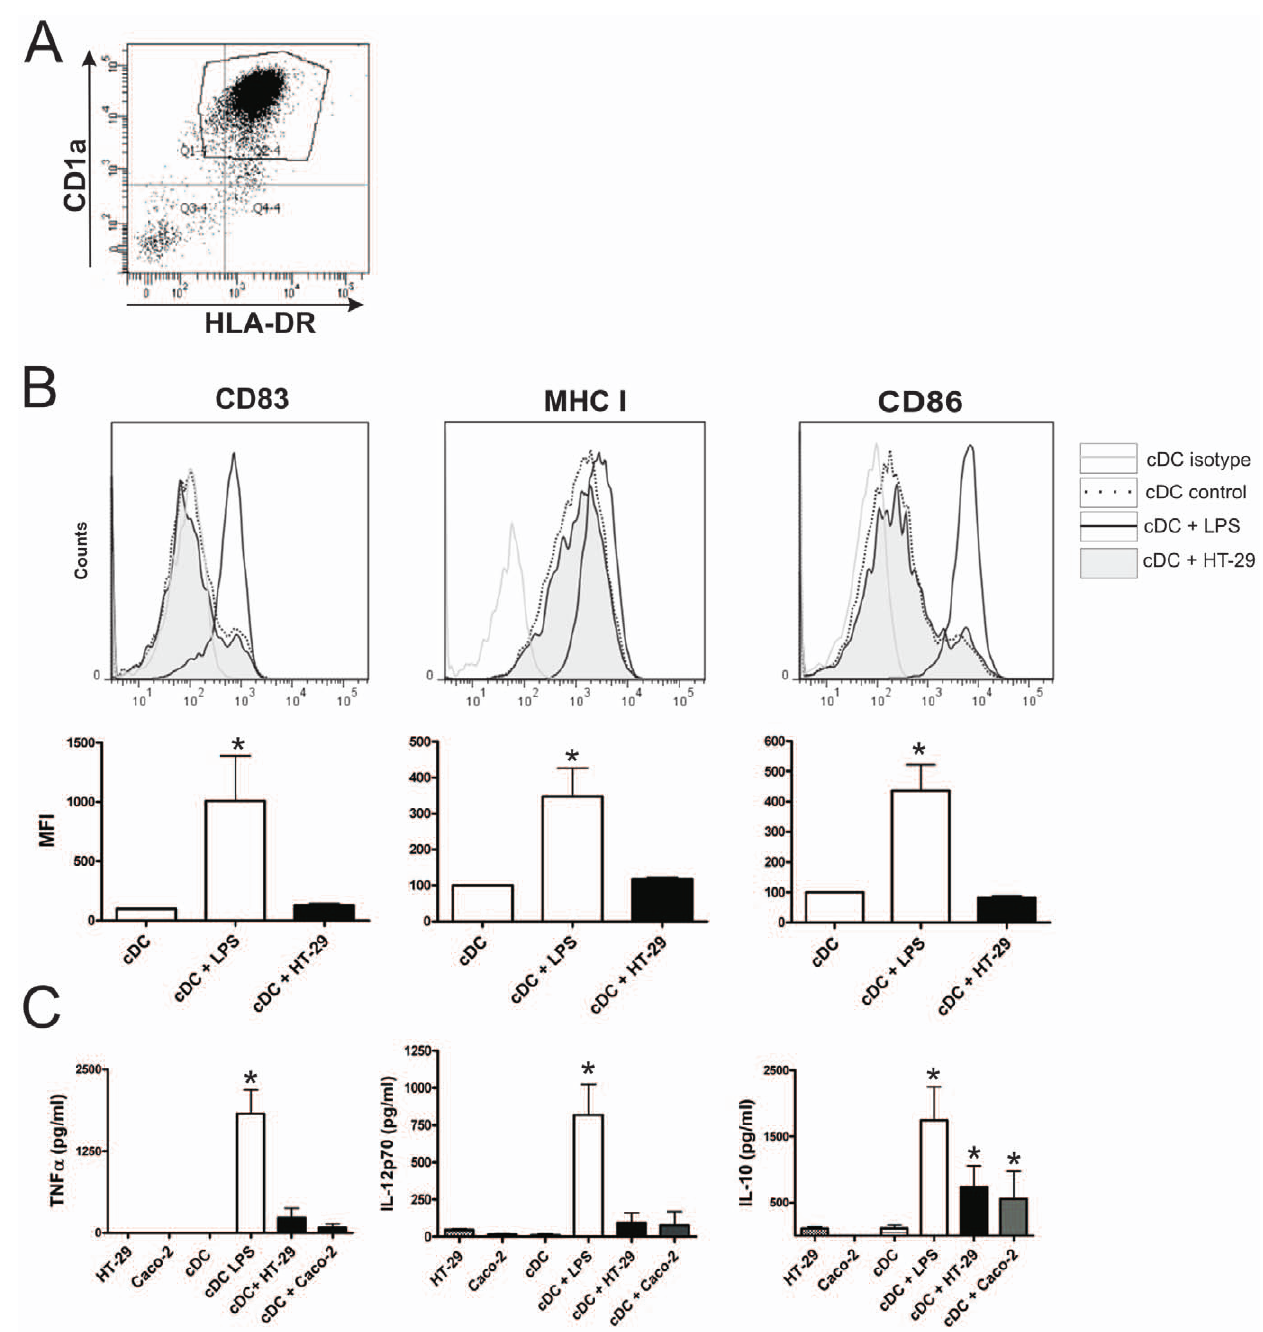
Figure 4. Epithelial cells induce neither the phenotypic maturation nor the stimulation of the production of inflammatory cytokines by cDCs. Conventional DCs were obtained from human monocytes ( . 85% purity) cultured for 5 days with GM-CSF plus IL-4. The epithelial cell lines HT-29 and Caco-2 were grown to confluence in 96 well, flat bottom plates. DCs (1 6 10 5 /200 m l) were cultured alone for 12 h, in the absence or presence of 100 ng/ml of LPS or in the presence of confluent monolayers of HT-29 or Caco-2 cells, in 96 well flat bottom plates. ( A ) Dot-plots illustrating the purity of cDCs and the expression of CD1a and HLA-DR. ( B ) The expression of CD83, MHC class I, and CD86 was analyzed by flow cytometry in the gate of CD1a + cells and a representative experiment (n=5–7) is shown. Graph bars show the MFI of CD83, MHC class I, and CD86. The MFI of cDCs cultured alone is assigned the value of 100. Results are the mean 6 SEM of 7–10 experiments. (* p , 0.05 vs cDCs). ( C ) The production of TNF- a , IL-12p70, and IL-10 was evaluated in cell supernatants by ELISA. Results are the mean 6 SEM of 7–10 experiments performed in duplicate. (* p , 0.05 vs controls). doi:10.1371/journal.pone.0028709.g004 pDCs preincubated with epithelial cells during 12 h. No anti-HIV activity was observed using supernatants collected from pDCs or Figure 8A shows that pDCs prevented the infection of GHOST cells and that this anti-HIV activity was further improved using HT-29 cells cultured alone. By contrast, supernatants collected